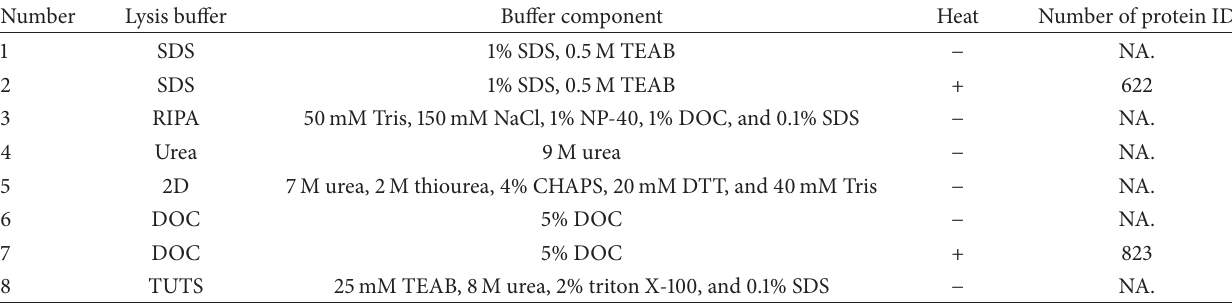
Table 1: Overview of the various lysis buffer and the number of proteins identified using 1D LC-MS/MS shotgun